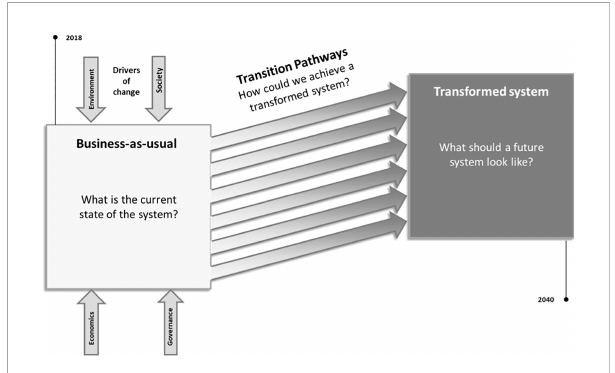
FIGURE 1 A conceptual model of transformation for extensive grazing of rangeland systems (Adapted from Jacobs et al.,